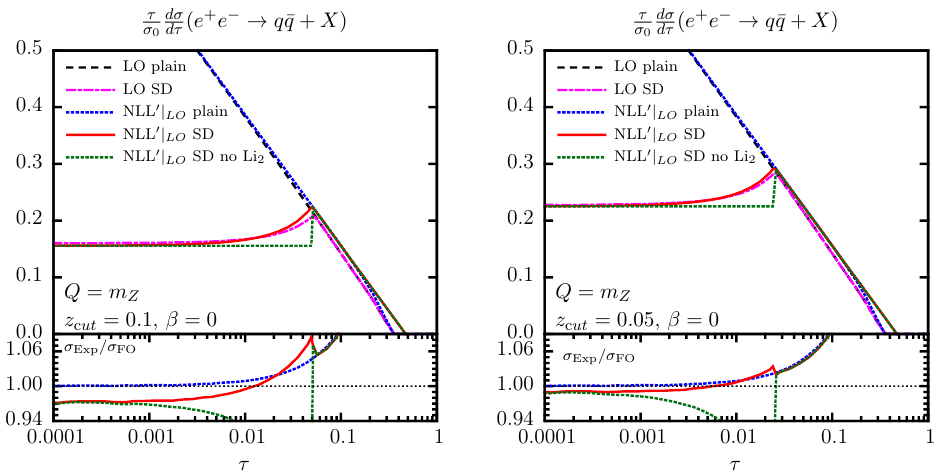
Figure 5 . A comparison between the (cid:12)xed order and expansion of the di(cid:11)erential cross section of the plain and soft-dropped thrust for e + e (cid:0) collisions at a centre of mass energy Q = m Z and the soft drop parameters (cid:12) = 0 and z cut = 0 : 1 (left) and z cut = 0 : 05 (right). The (cid:12)gure shows LO for plain thrust (black dashed) and soft-dropped thrust (magenta dashed-dotted) and the expansion for plain thrust (blue dotted) and soft-dropped thrust (red solid). The plots at the bottom show the ratio of the expansions to their (cid:12)xed-order